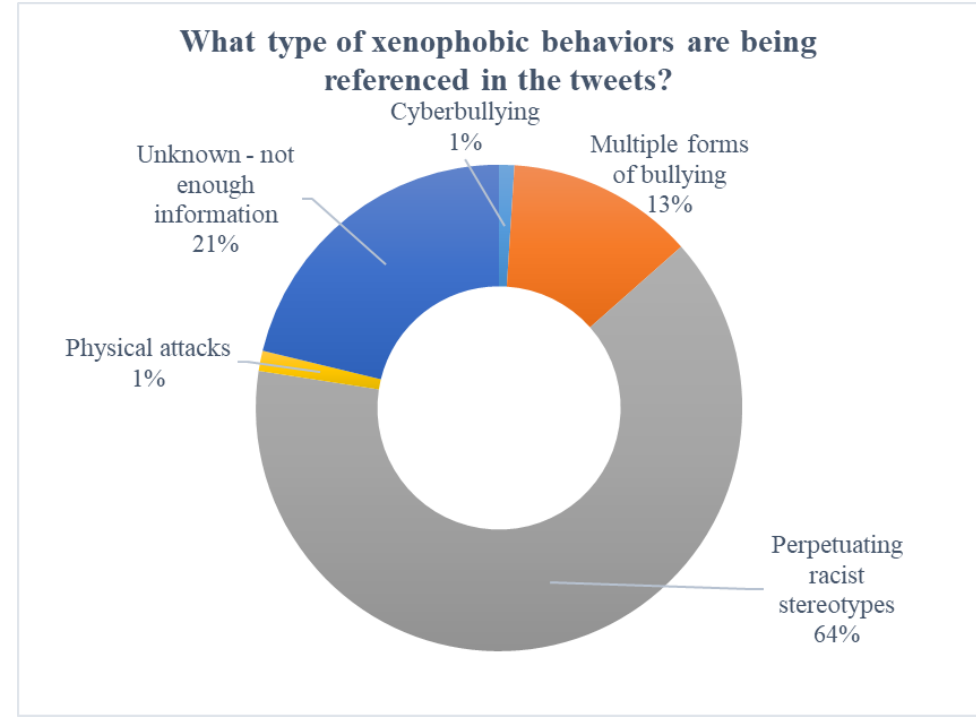
Figure 3. Type of xenophobic behaviors.